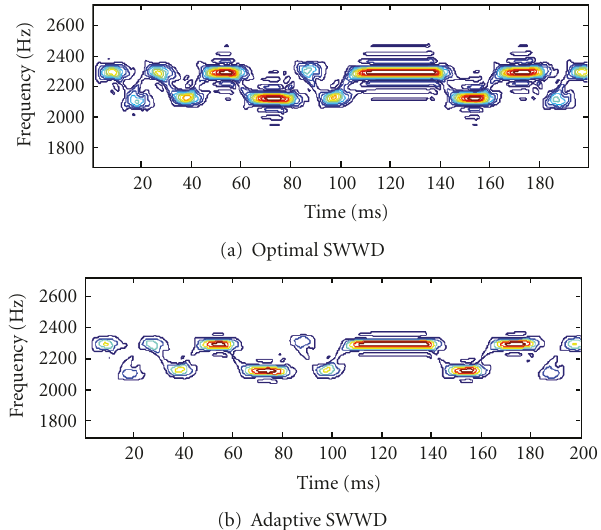
Figure 10: The TFR using optimal SWWVD and using adaptive SWWVD of FSK3.